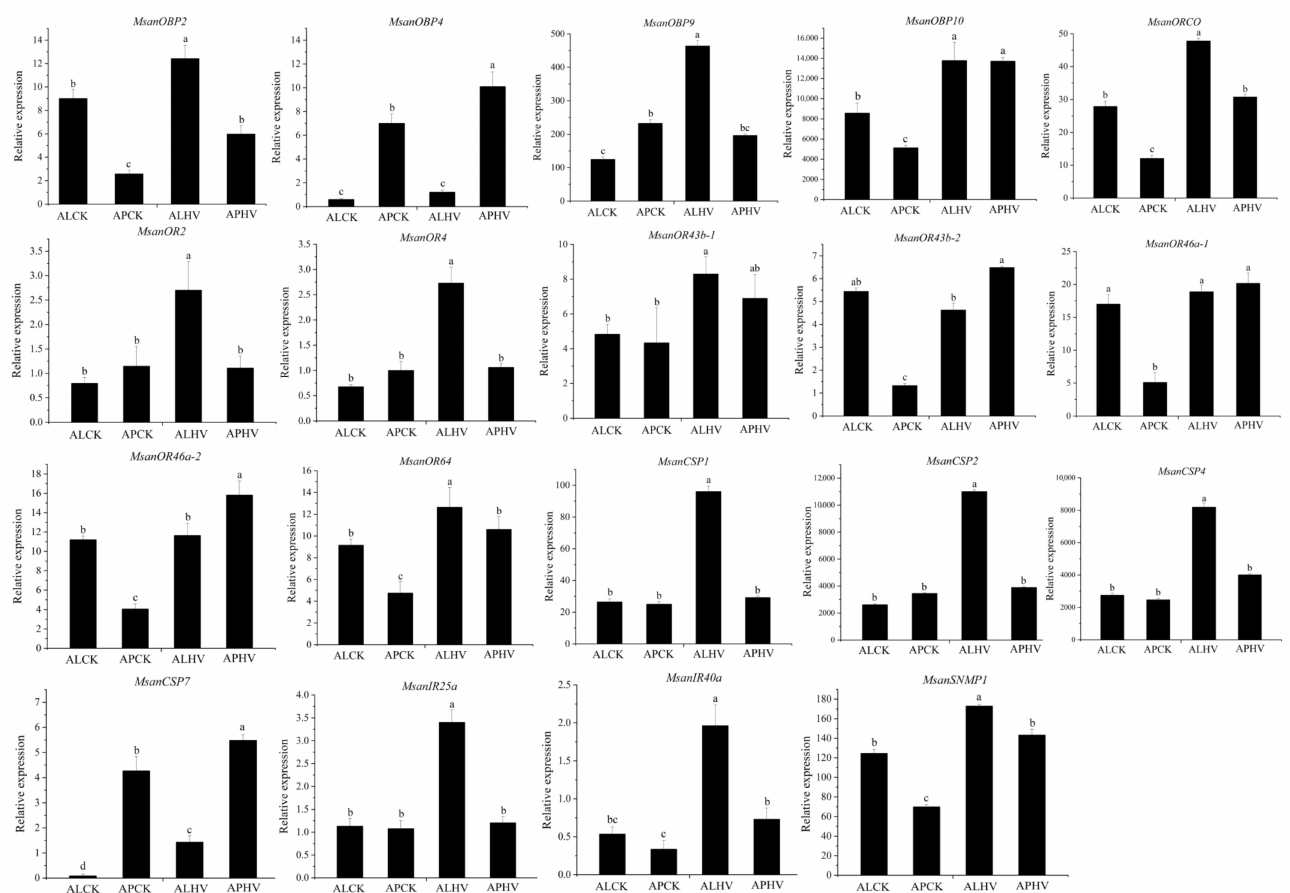
Figure 9. Odor- and wing-specific expression of candidate chemosensory genes of M. sanborni . ALCK: alate aphid under control condition, APCK: apterous aphid under control condition, ALHV: alate aphid under the effect of host volatiles, APHV: apterous aphid under the effect of host volatiles. Columns labeled with different letters are significantly different ( p <